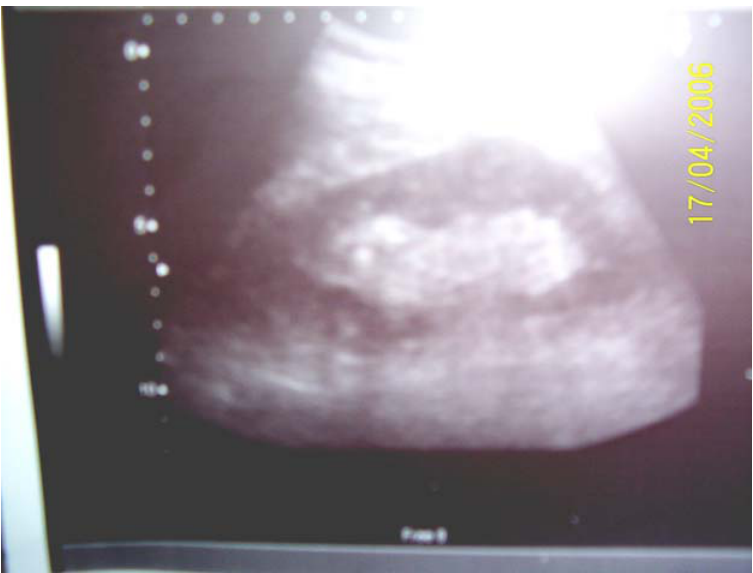
FIGURE 2. Left kidney ultrasound (4/17/06). There are not signs of hydronephrosis, lithiasis or urinary extravasation.